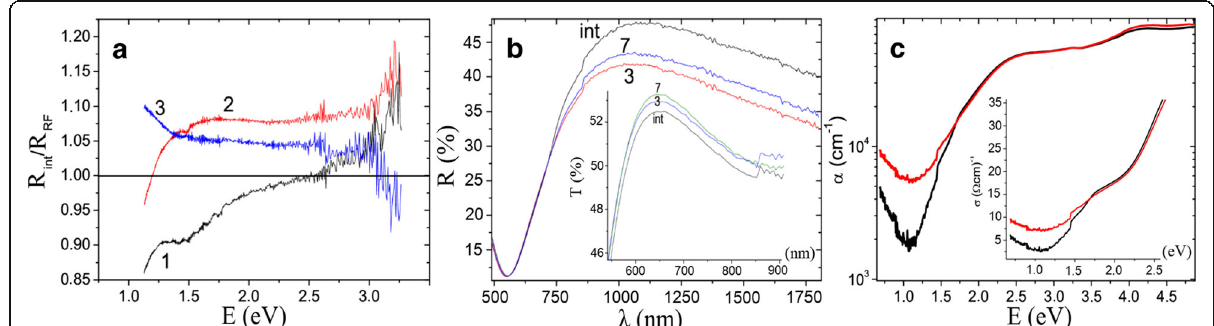
Fig. 2 Optical spectra of CZTSSe before and after RF treatments. a 1 Ratio of reflectances for bulk CZTS processed from metallic precursors (A setup); 2 ratio of reflectances for glass/Mo/Cu/CZTSe (A setup); 3 reflectance of bulk CZTS processed from sulfide precursors (B d setup). b Reflectance and transmittance ( insert ) of CZTS with respect to plasma exposure (C setup) with the steps of 1, 3, and 7. c Spectra of absorbance of CZTS thin films with ( black ) and without ( red ) RF treatment during 3 min (C setup). Insert : optical conductivity spectra of the same